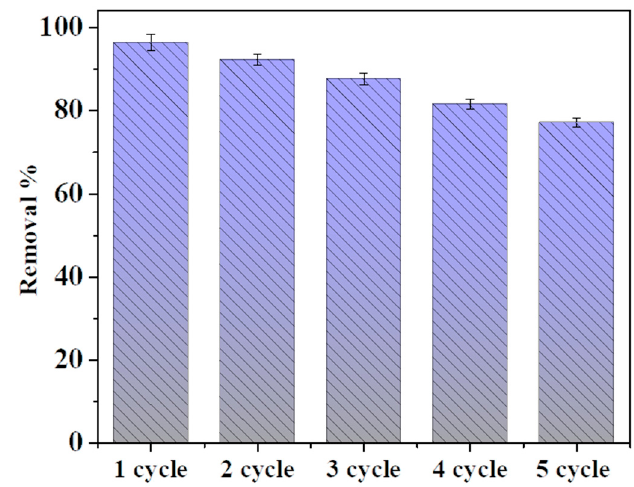
Figure 6. Regeneration study of Fe 3 O 4 NPs material.